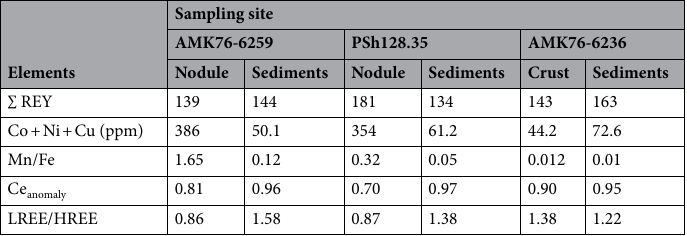
Table 1. Element composition of nodules, crust and underlying sediments from the Kara Sea. Ce